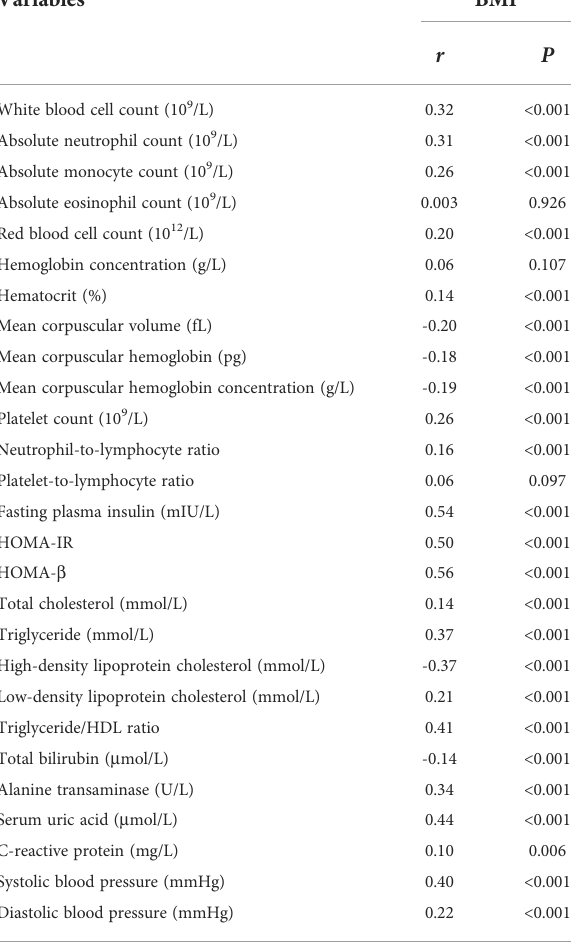
TABLE 2 Partial correlation analysis of BMI and clinical indicators adjusted for age and sex in all children.